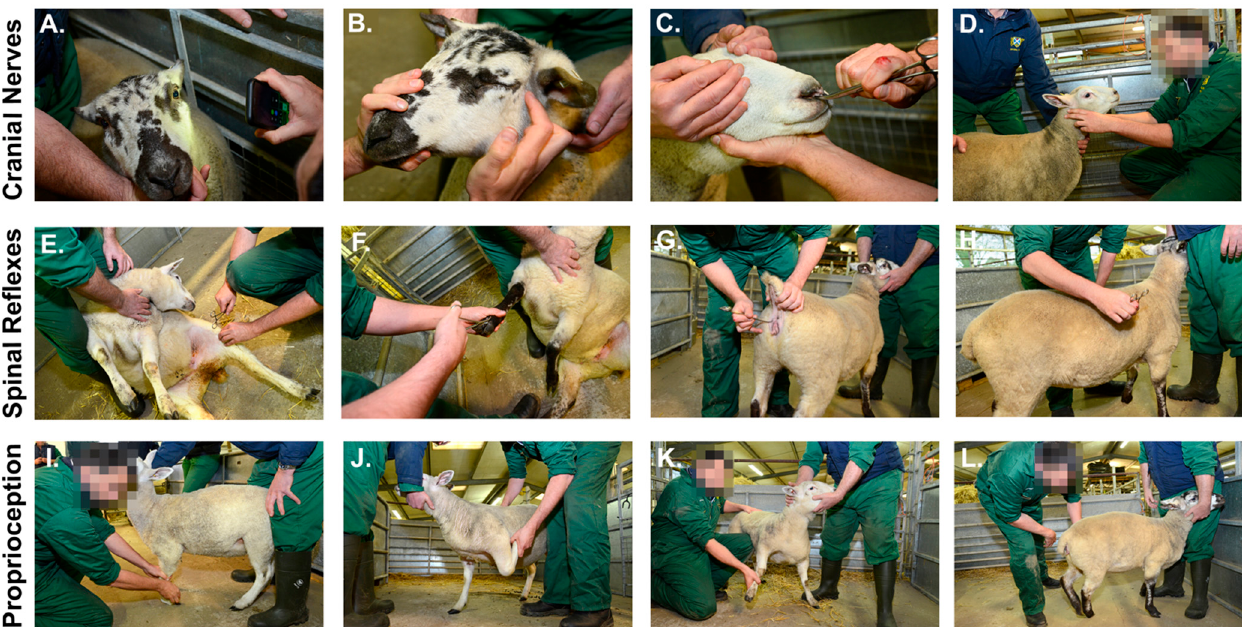
Figure 2. Selection of commonly examined reflexes and reactions to assess neurological function. ( A – D ) illustrates cranial nerve assessments with ( A ) pupillary light reflex (PLR), ( B ) palpebral reflex, ( C ) nasal sensation, ( D ) facial symmetry. ( E – H ) illustrates spinal reflex exams with ( E ) patellar reflex, ( F ) withdrawal reflex, ( G ) perineal reflex and ( H ) cutaneous trunci reflex. ( I – L ) demonstrates proprioceptive positioning with ( I ) knuckling/hoof placement test, ( J ) hop test, ( K ) step/visual and tactile placing test and ( L ) push test.